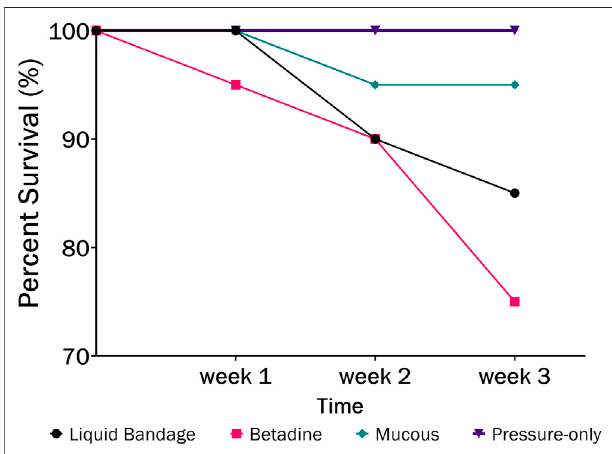
FIGURE 3 | The percent survival of fi sh after 3-weeks recovery following blood sampling in the laboratory wherein different post-sampling treatments were applied to the wound (liquid bandage: black, Betadine ™ : red, fi sh mucous: green, pressure-only: